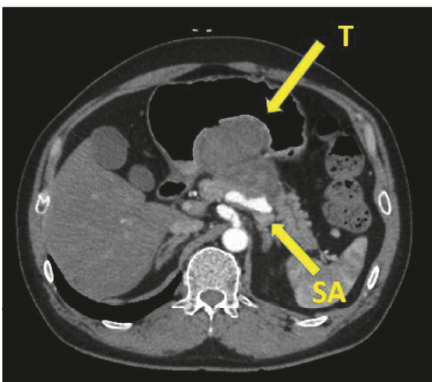
Figure 2: Computed tomography indicated a tumor measuring 65× 50 mm in the stomach, which was suspected to have invaded into the pancreas, but no metastatic lesions were detected. T: tumor; SA: splenic.